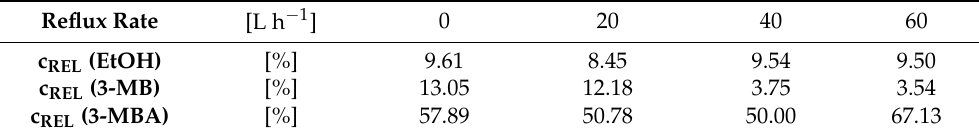
Table 3. Values for the c REL of ethanol (EtOH) and of the aroma compounds 3-methylbutanol (3-MB), used as a representative of higher alcohols, and 3-methylbutyl acetate (3-MBA), used as a representative of esters, given as a function of the chosen reflux rate. The temperature of the condenser remained constant at 10 °C. c REL represents the percentage ratio between the concentration of the particular compound in the aromawater and the one in the condensate.